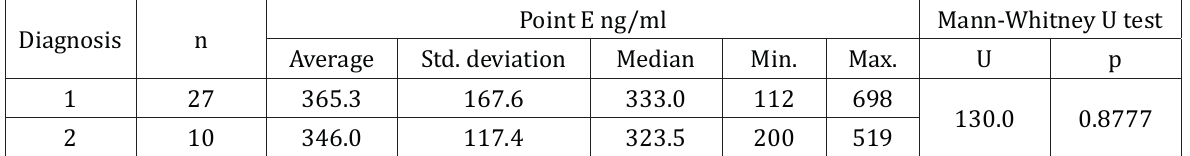
Table 16. Descriptive statistics – Concentration of MMP-9 at the end point of the study in patients with different diagnoses and the result of a Mann-Whitney U test